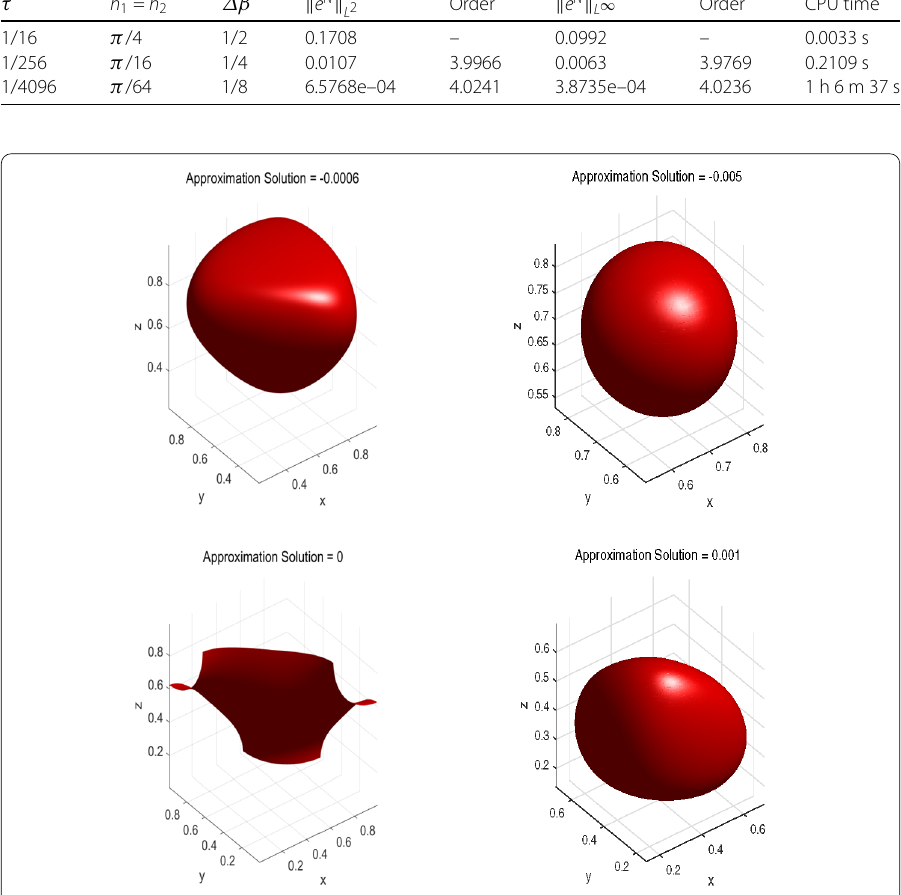
Figure 4 The graphs of isosurfaces for the approximate solution with different isovalues by scheme (59)–(61) (Example